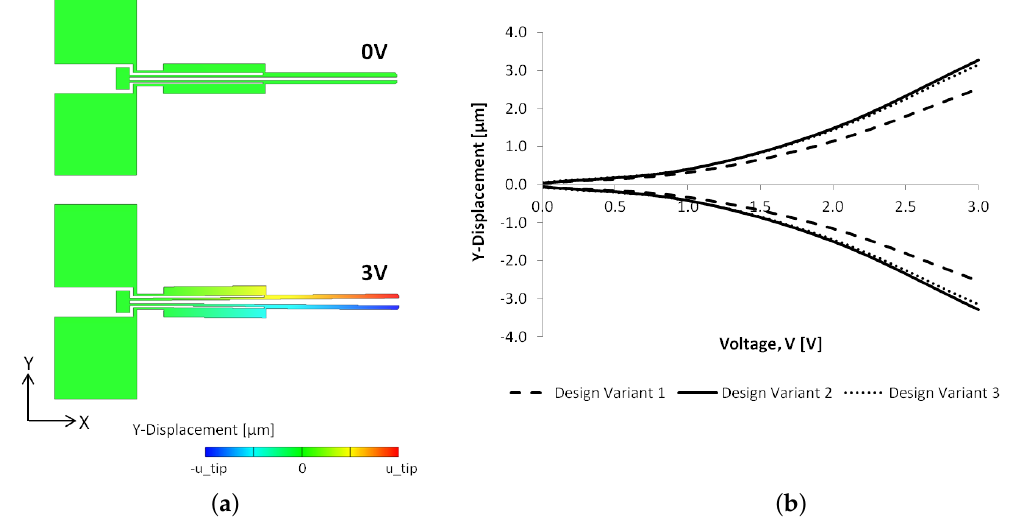
Figure 11. Simulated steady-state lateral displacement distribution on the polysilicon microgripper structures fabricated with PolyMUMPs TM (Design Variants 1-3). The simulated plots in ( a ) show the y -displacement distribution with and without an applied potential for Design Variants 1-3. The absolute gap opening in the closed position (i.e., when not actuated), u o , is 5 µ m with this absolute gap increasing to u o + 2 u tip when actuated. The relative opening stroke of each microgripper arm tip is then quantified with applied potential in ( b ) for each specific design